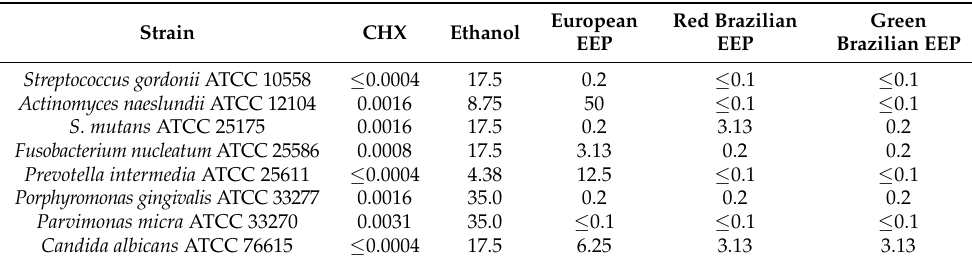
Table 1. MIC values of propolis (mg/mL) in the different ethanolic preparations (EEP), chlorhexidine digluconate (CHX; %), and ethanol (%).